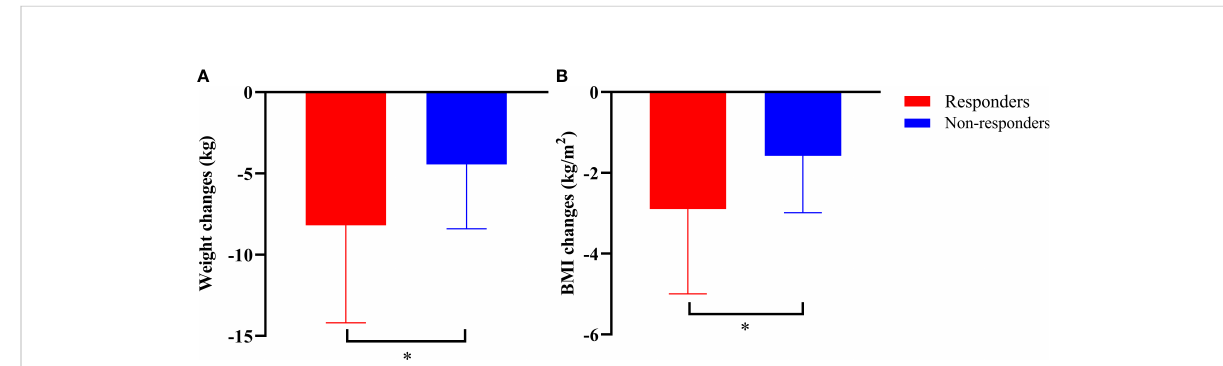
FIGURE 3 Body weight (A) and BMI (B) at the last follow-up in responders and non-responders compared to those at baseline. * P <0.05, responders vs.